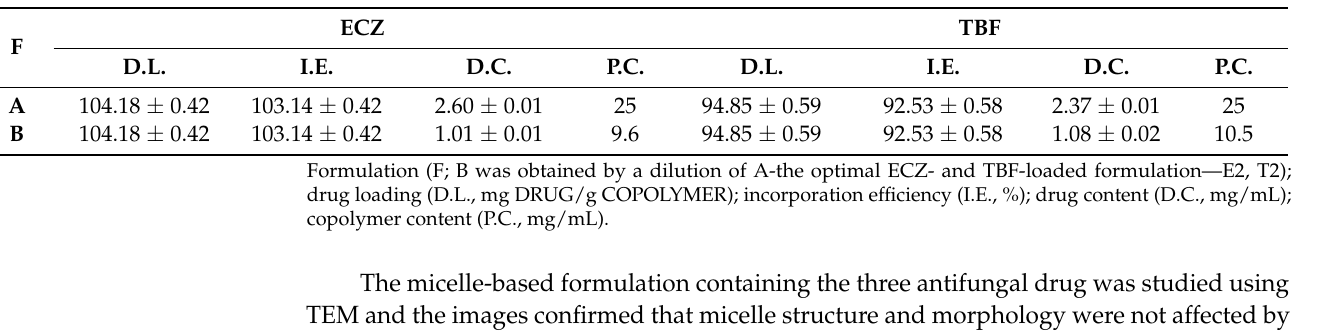
Table 3. Content of ECZ- and TBF-loaded